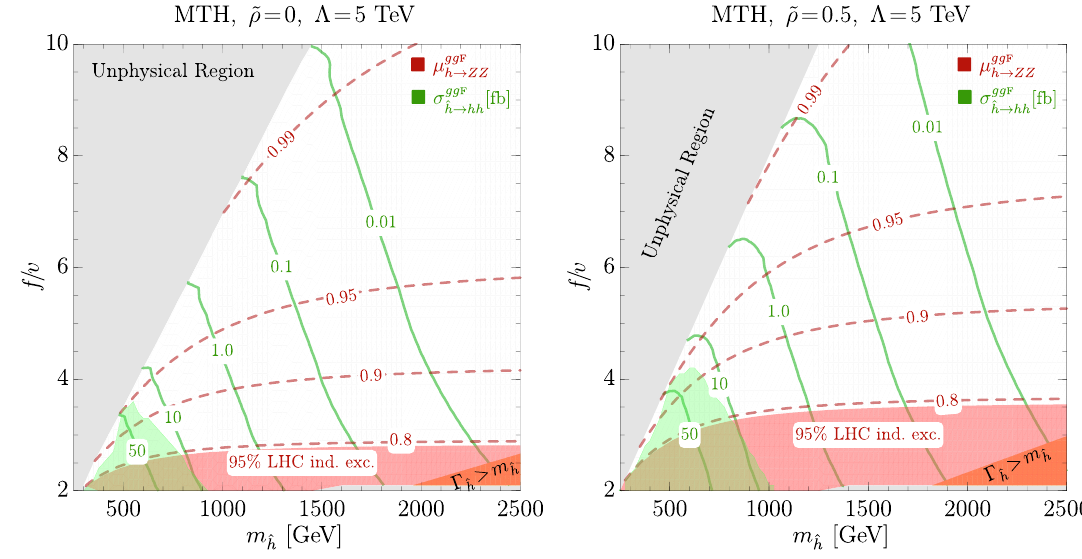
Figure 6 . These plots show parameter space in m ^ (cid:0) f=v plane for the MTH model. The contours h of heavy twin Higgs cross-section to a pair SM Higgs bosons (cid:27) gg f [fb] (solid green) and SM Higgs ^ h ! hh signal-strength (cid:22) gg f (dashed red) are shown for ~ (cid:26) = 0 (left) and ~ (cid:26) = 0 : 5 (right). Shaded regions h ! ZZ read as: unphysical parameters (gray), (cid:0) ^ > m ^ (orange), the projected reach for direct searches h h ^ h ! hh at the HL-LHC (light-green), and exclusion by the SM Higgs signal-strength measurements at the LHC run-1 (red).